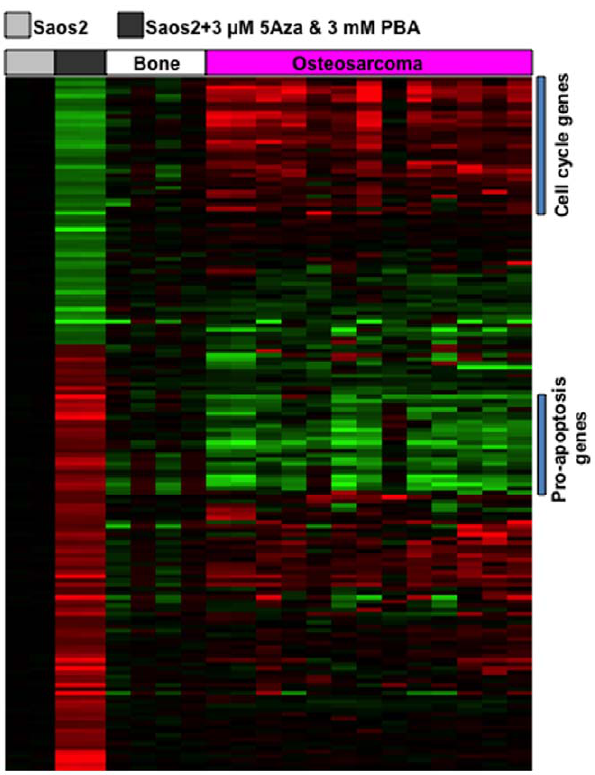
Figure 4. Genome-wide gene expression changes induced by treatment of 5-AzadC and 4-PBA in Saos2 cells. mRNA expression patterns in Saos2 cells treated with 3.0 m M 5-AzadC and 3.0 mM 4-PBA relative to sham treated Saos2 cells. mRNA expression profiles in normal bone (n=4) and OS patient samples (n=13) were used for comparison and shown relative to normal bone. The heatmap with gene names are detailed in Figure S2.